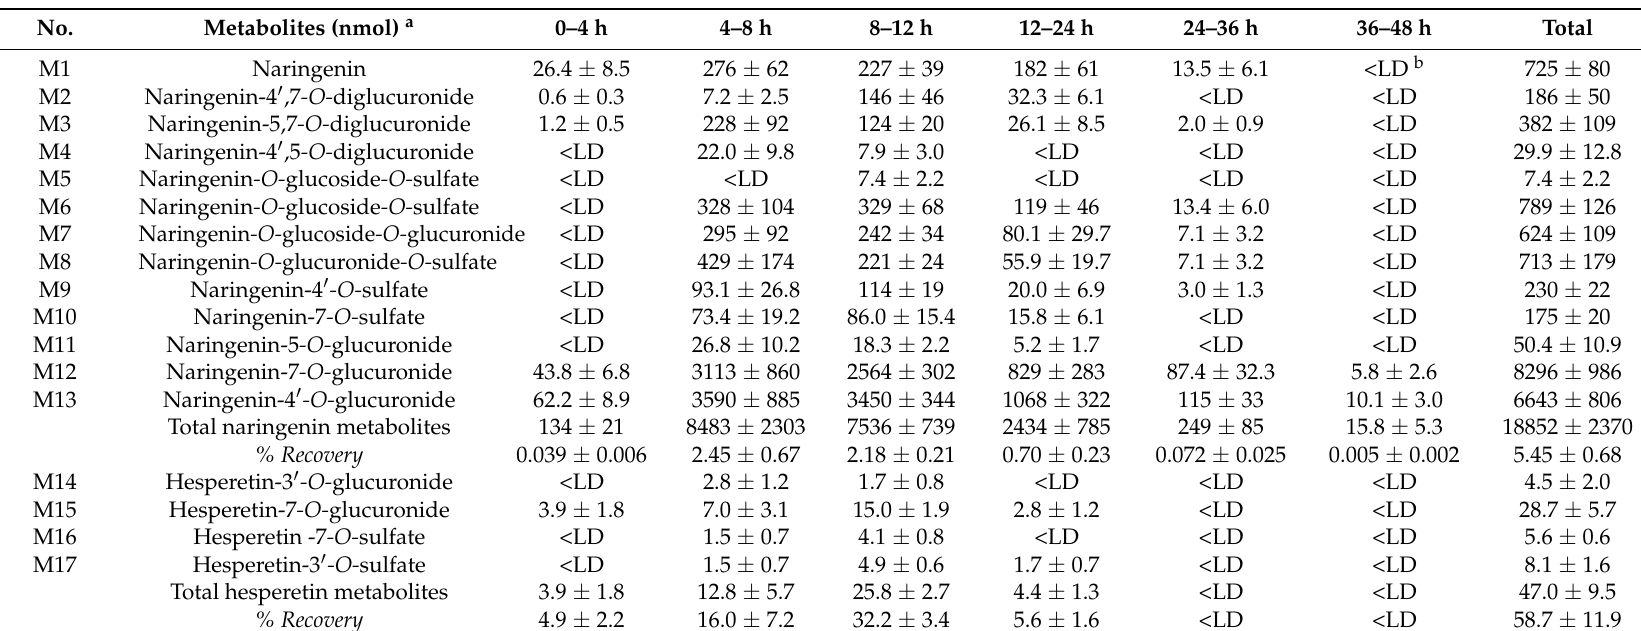
Table 3. Quantification of metabolites of naringenin and hesperetin in the urine after the ingestion of 250 mL ECG extract containing glycosides of naringenin (346 µ mol), and hesperetin (0.08 µ